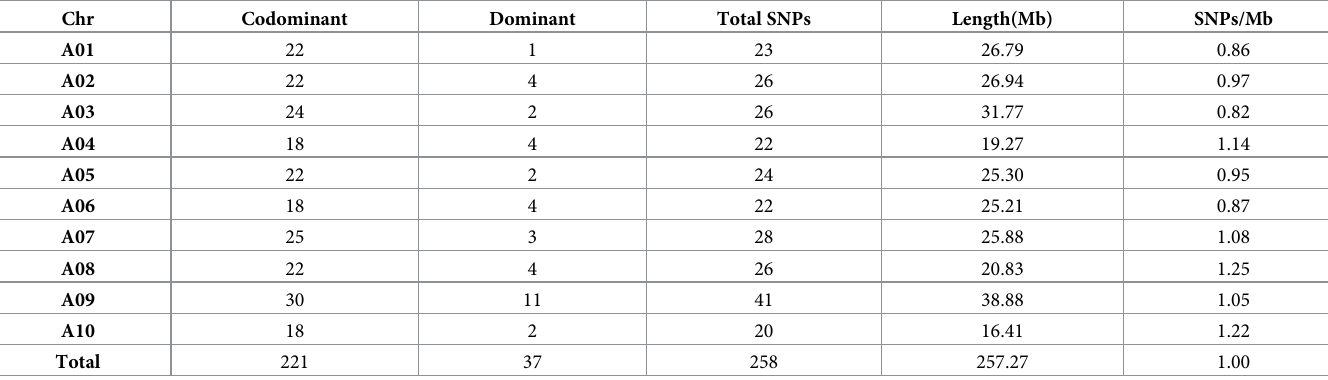
Table 3. Distribution and number of KASP-SNP markers in Chinese cabbage.